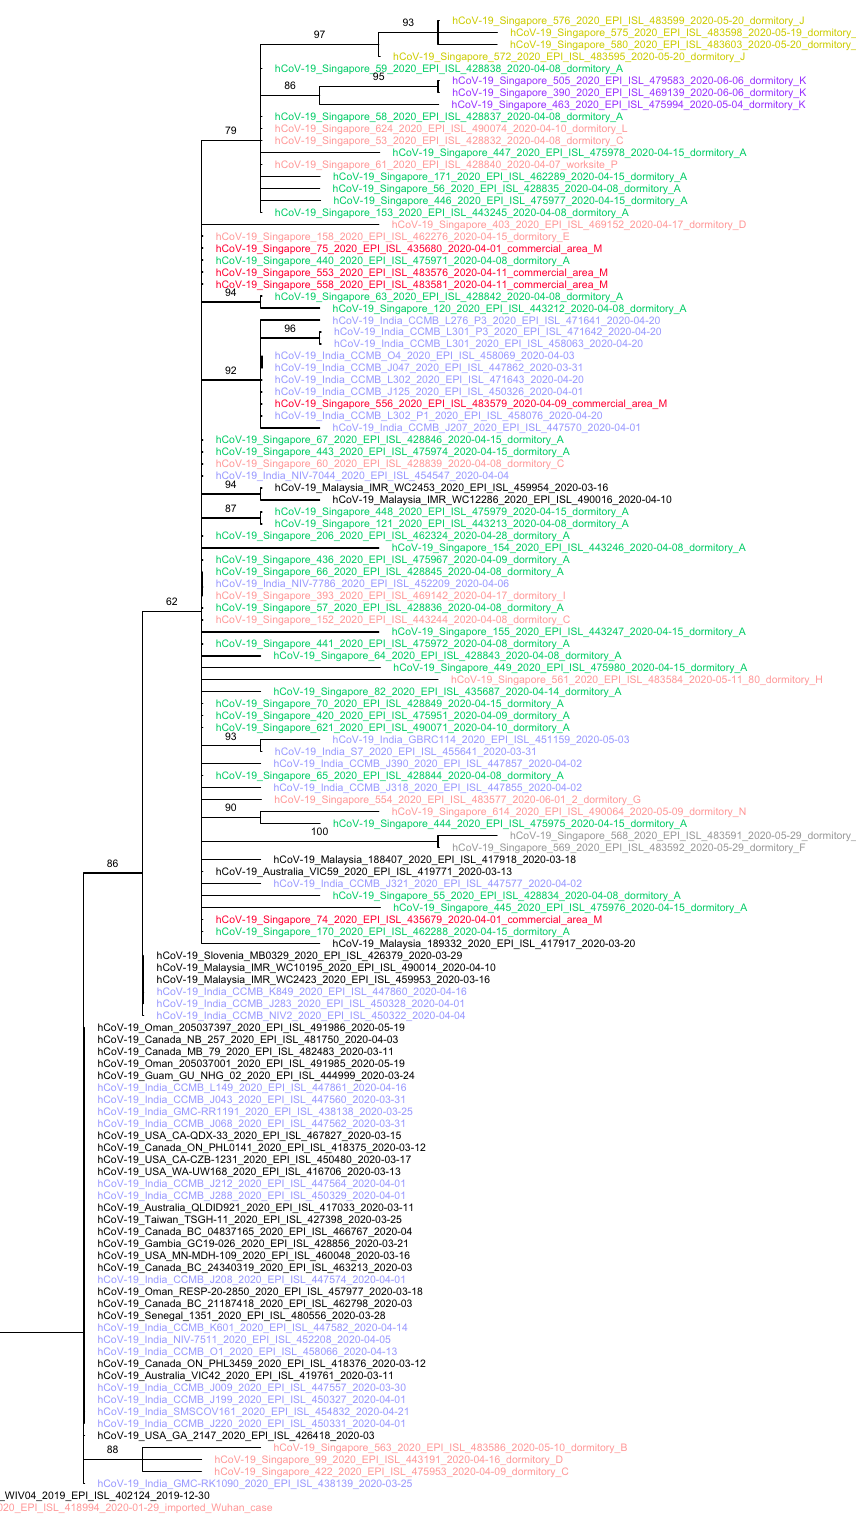
Figure 4. Phylogenetic tree plotted based on available samples from the dormitory cases and those linked to the dormitory outbreak. Selected genomes in the GISAID database was also plotted to place the sequences from locally notified cases into the global